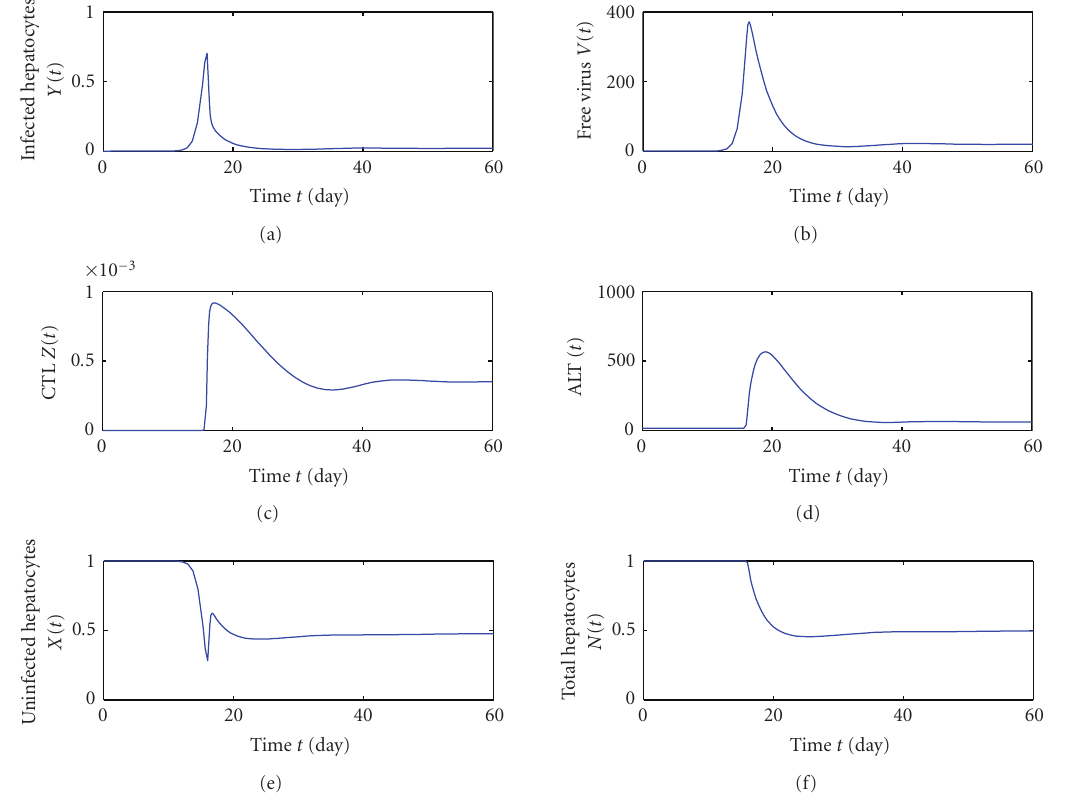
Figure 3: Acute–turn-chronic